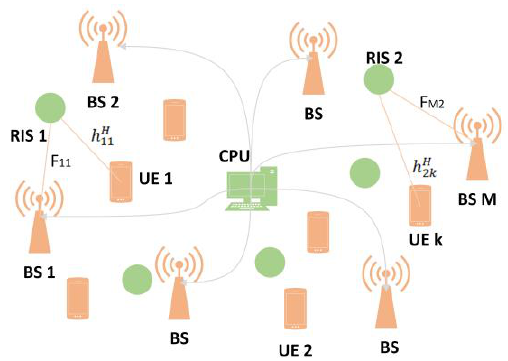
Figure 2. An RIS-assisted cell-free communication system.